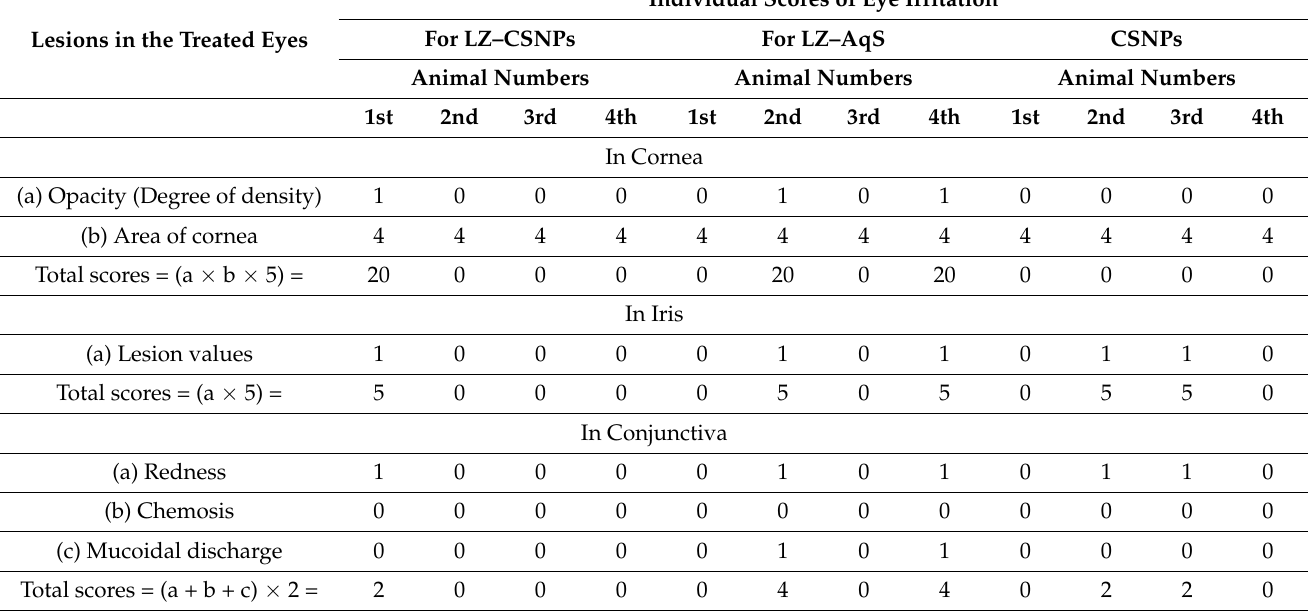
Table 5. Weighted scores for irritation test of LZ–CSNPs, LZ–AqS and CSNPs in rabbit